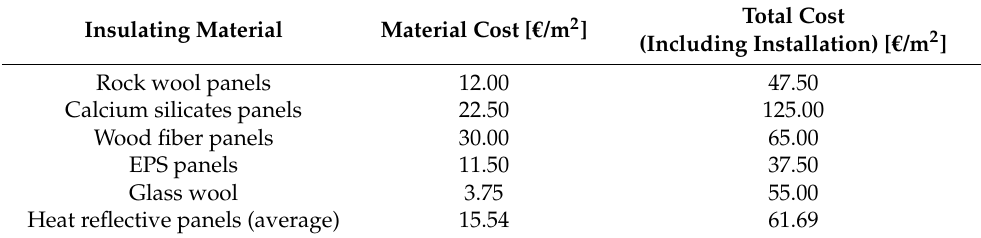
Table 8. Costs of traditional and heat reflective thermal insulation materials.